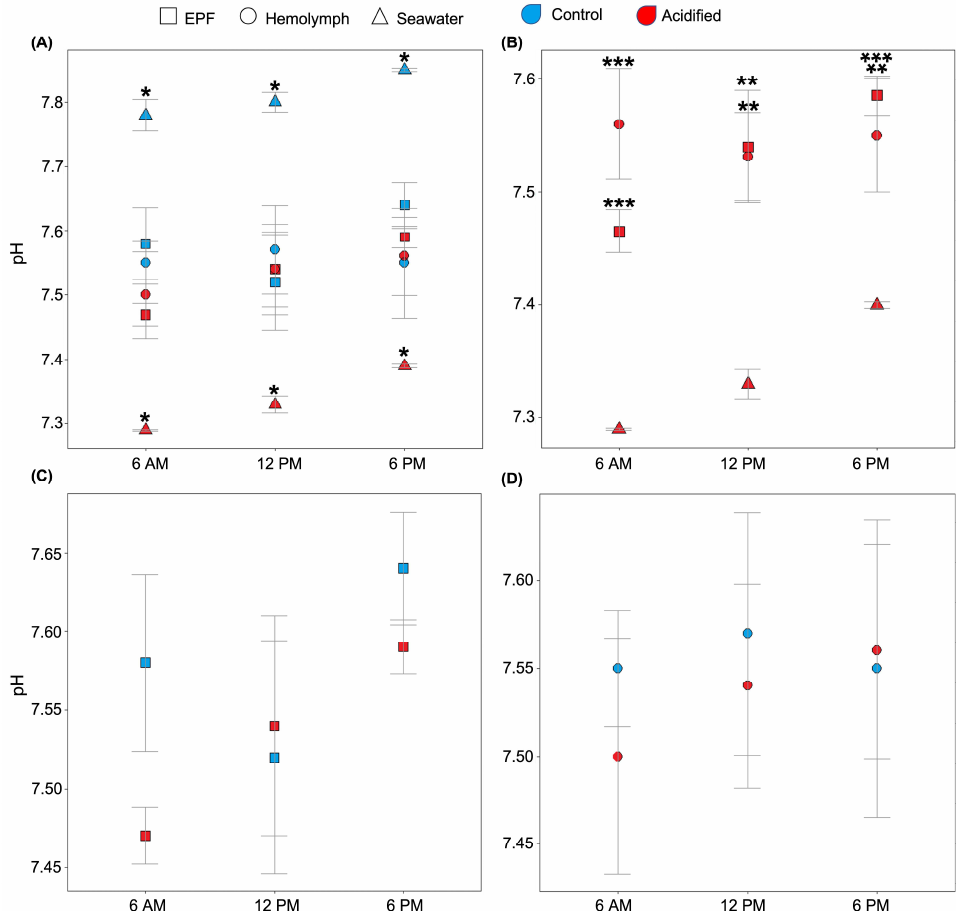
Figure 1. EPF (squares) and hemolymph (circles) pHs of clams under different p CO 2 conditions (red: acidified; blue: control) were measured over a 12 h period. ( A ) Seawater (triangles) pH from both conditions was significantly different from the EPF and hemolymph pHs of the corresponding clams (asterisks denotes significant differences). ( B ) Under the OA conditions, the pHs of both EPF and hemolymph were significantly higher than seawater pH at every time point (* <0.05; ** <0.01; *** <0.001). ( C ) There were no significant differences between EPF pHs of clams in OA and control conditions. ( D ) There were no significant differences between hemolymph pHs of clams in OA and control conditions. n = 4; Student’s t -test; p < 0.05; means ± standard errors.